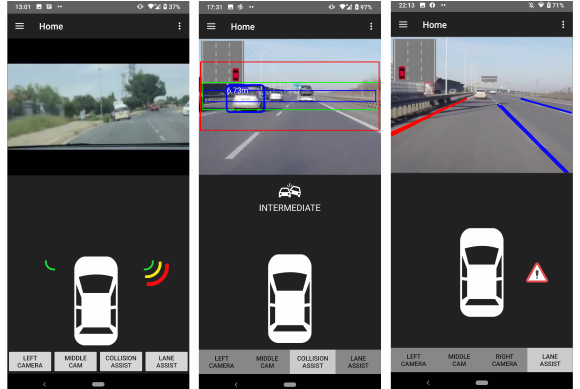
Figure 22. Screenshots of different detection types running the ADAS on